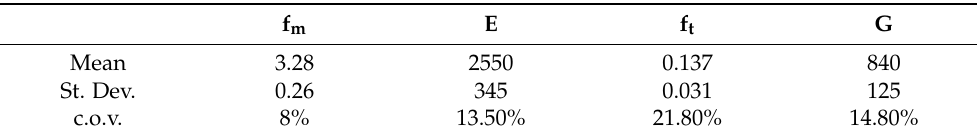
Table 2. Mechanical properties (compressive strength f m , elastic modulus E, tensile strength f t and shear modulus) of stone masonry in MPa. f m E f t G Mean 3.28 2550 0.137 840 St. Dev. 0.26 345 0.031 125 c.o.v.